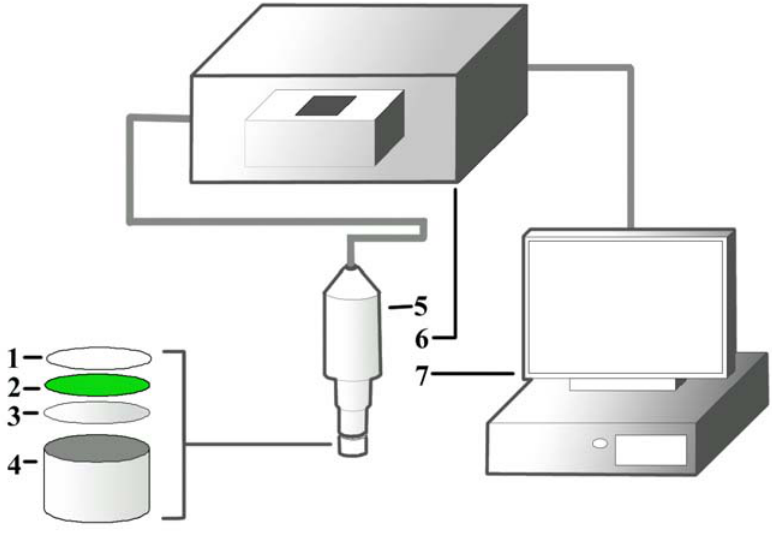
Figure 1. The hydrogel pHEMA (1) immobilizes the cyanobacteria (2) on a cellulose membrane (3) which was then attached to a well with d ≈ 0.8 cm (4). The well was attached to the optical probe (5), which was connected to the fluorescence spectrophotometer (6) and computer (7) for the detection of analytes (heavy metals and